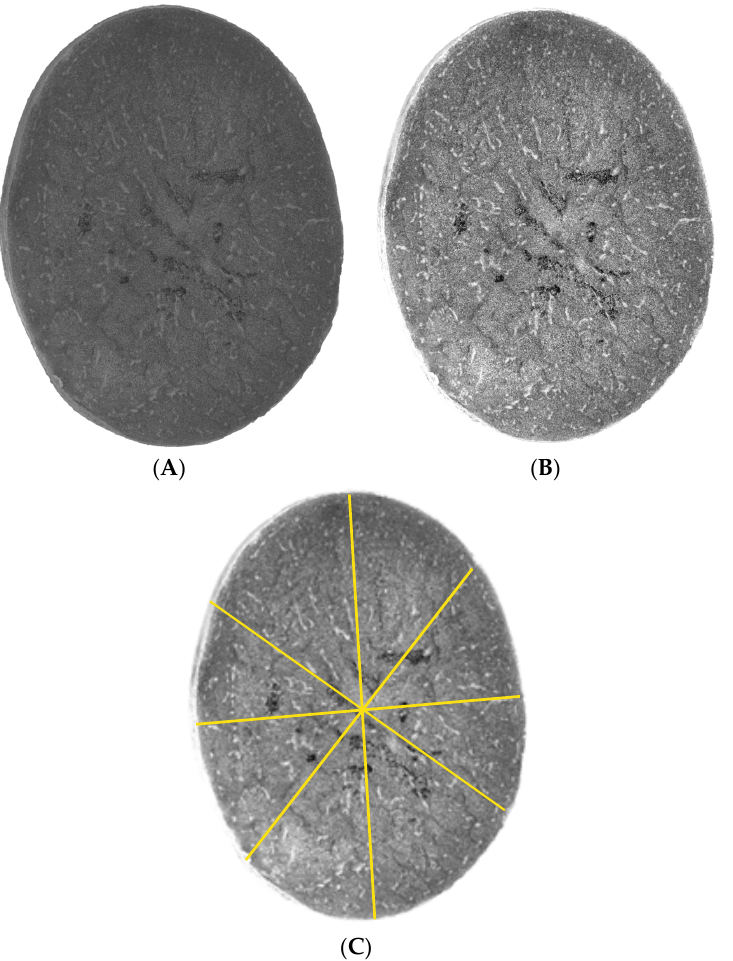
Figure 4. Scanned potato slice ( A ); image in 8-bit greyscale ( B ); image after contrast correction with determined measurement lines of histograms ( C ).